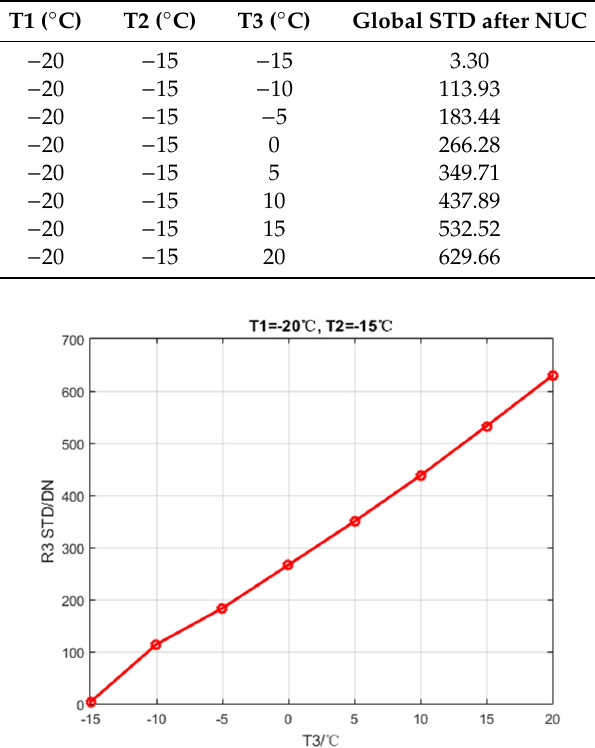
Figure 6. Global STD after NUC changes with T3.